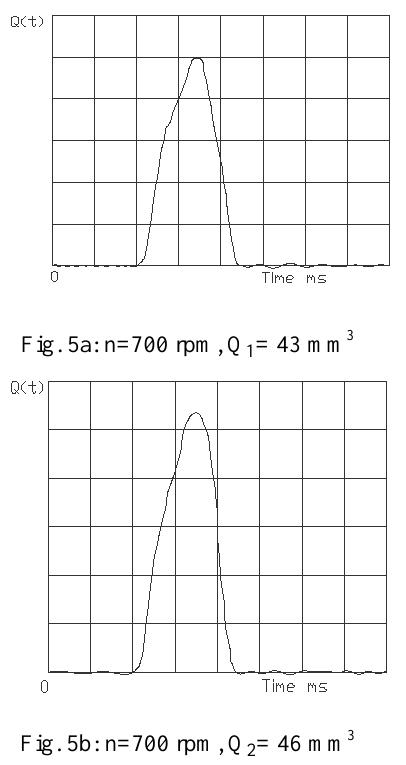
Fig. 5b: n=700 rpm, Q 2 = 46 mm 3